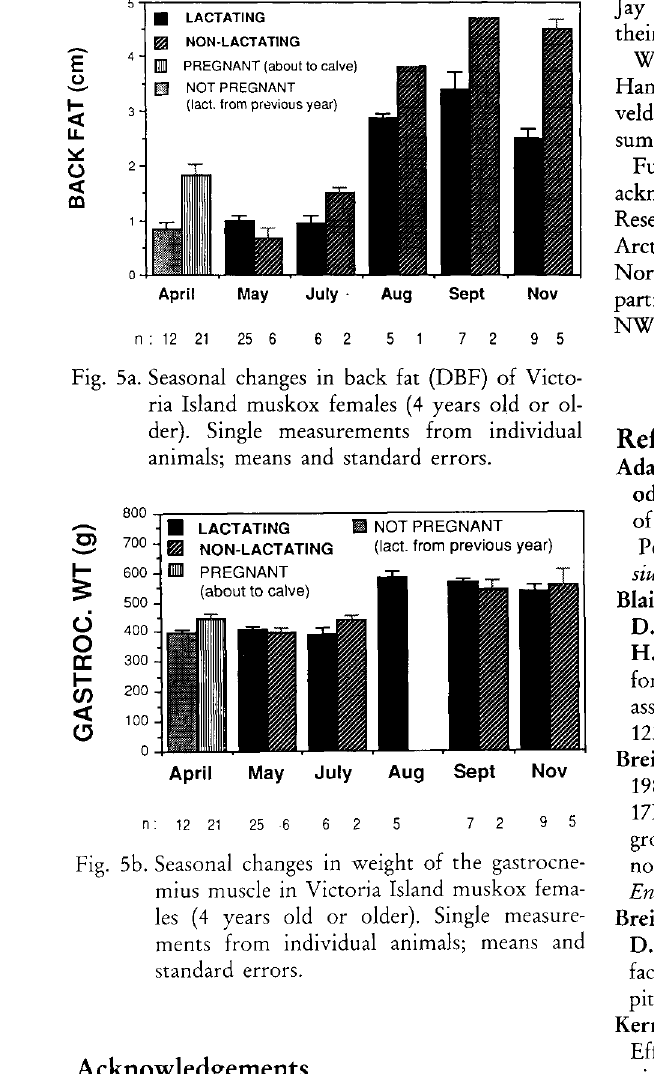
Fig. 5b. Seasonal changes in weight of the gastrocne mius muscle in Victoria Island muskox fema les (4 years old or older). Single measure ments from individual animals; means and standard